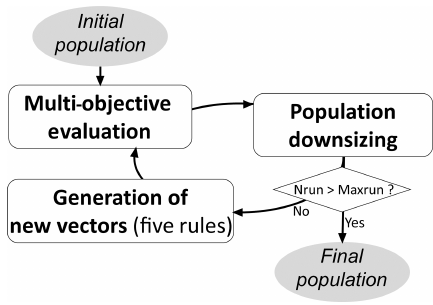
Figure 2. Flowchart of the caRamel